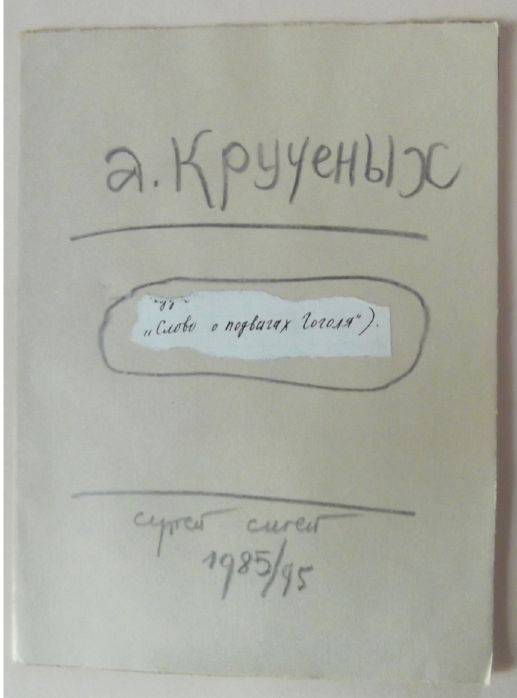
Figure 17. Third booklet.